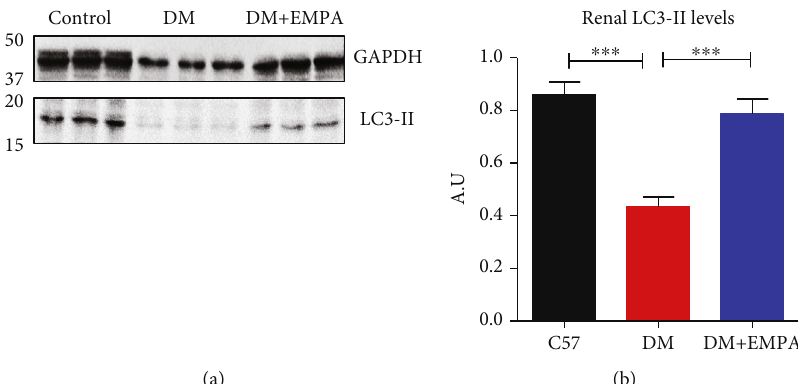
Figure 5: Renal LC3-II protein levels in C57/Bl, DM, and DM with EMPA lysates. (a) Representative randomly selected Western blots of LC3-II protein. (b) The signals were quanti fi ed by densitometry, and the ratio between LC3-II to GAPDH signals in the three groups was calculated.